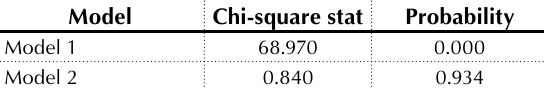
Table 7. Hausman test